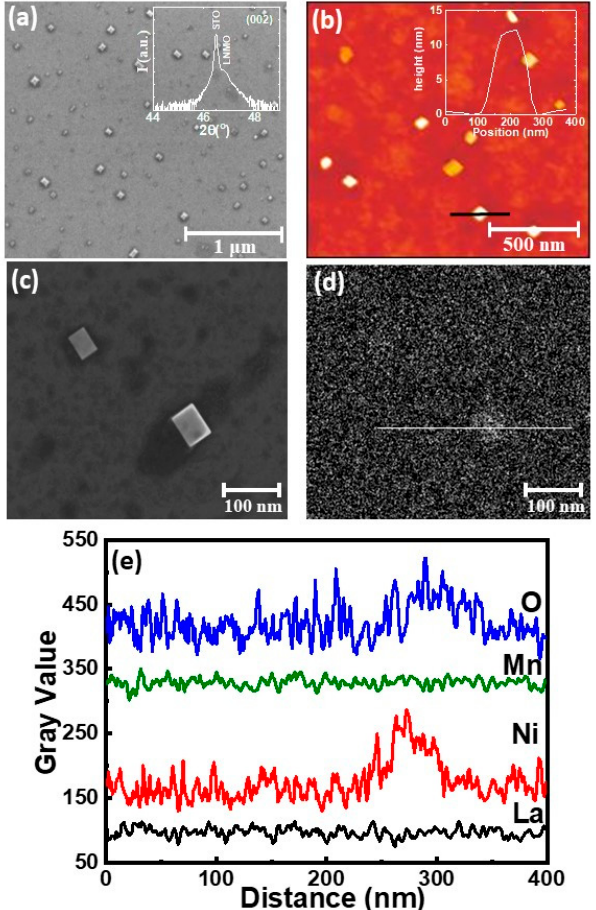
Figure 1. ( a ) SEM micrographs of LNMO-900 °C with in-situ annealing (thickness, t = 42 nm). Inset shows the θ /2 θ XRD pattern around 002 bragg peak of the substrate. ( b ) AFM image of LNMO-900 °C film with the height profile of one nanocuboid in the inset. ( c , d ) Small area SEM and EDX map at energy of E = 15 eV with the corresponding profile spectra of different elements by X-ray spectroscopy analysis in ( e ).